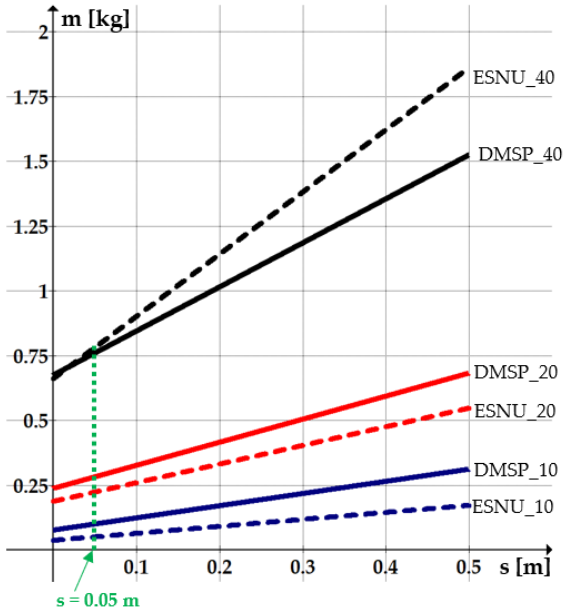
Figure 3. Dependency of the masses of the studied pneumatic motors on the stroke (m = f(s)).